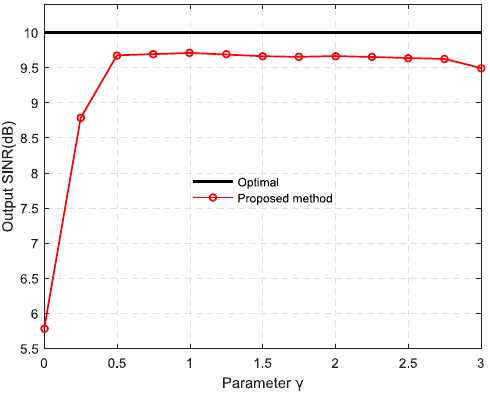
Figure 8. Output SINR versus parameter γ .